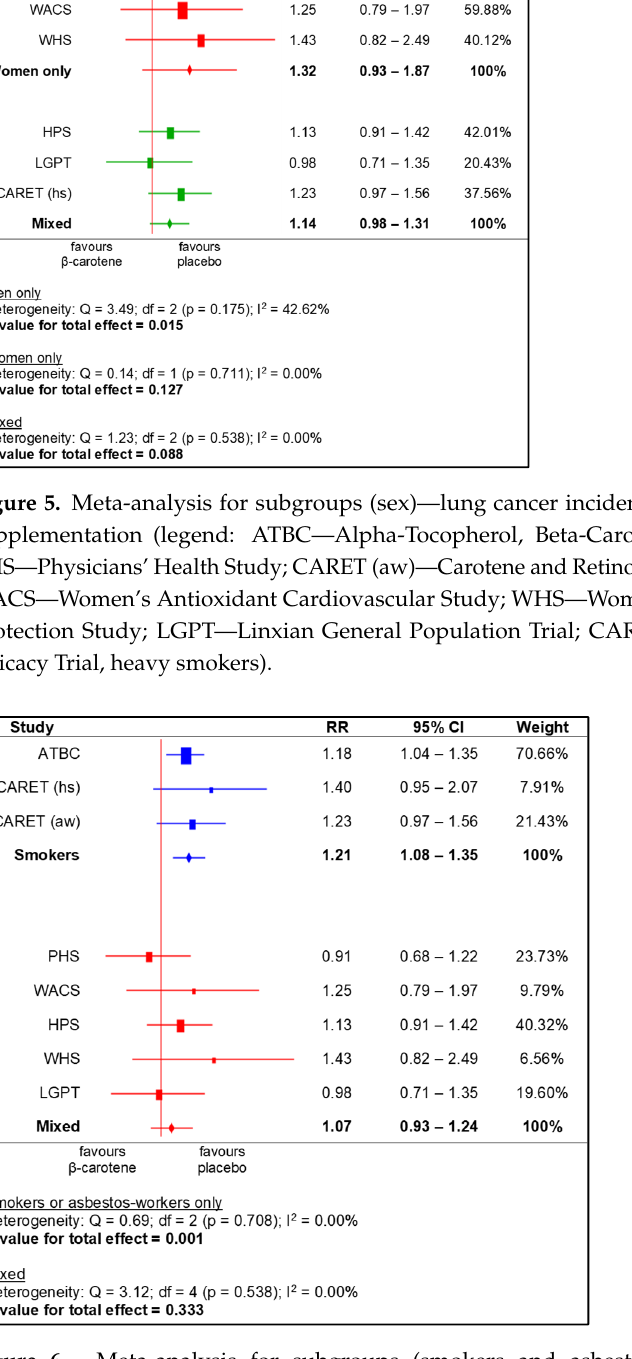
Figure 6. Meta-analysis for subgroups (smokers and asbestos-workers)—lung cancer incidence de- Figure